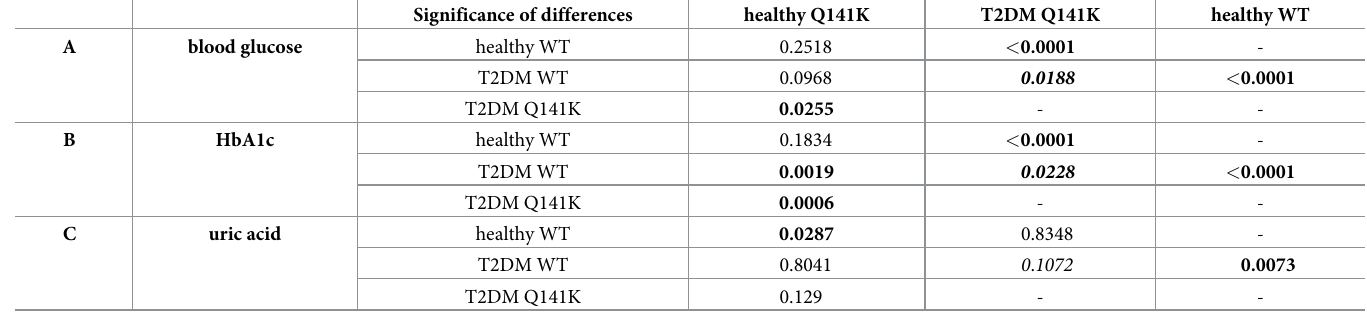
Table 3. Statistical analysis of the correlation of blood glucose (Panel A), HbA1c (Panel B) or uric acid (Panel C) levels and the presence of the Q141K variant in the groups of healthy individuals and T2DM patients. Significance of